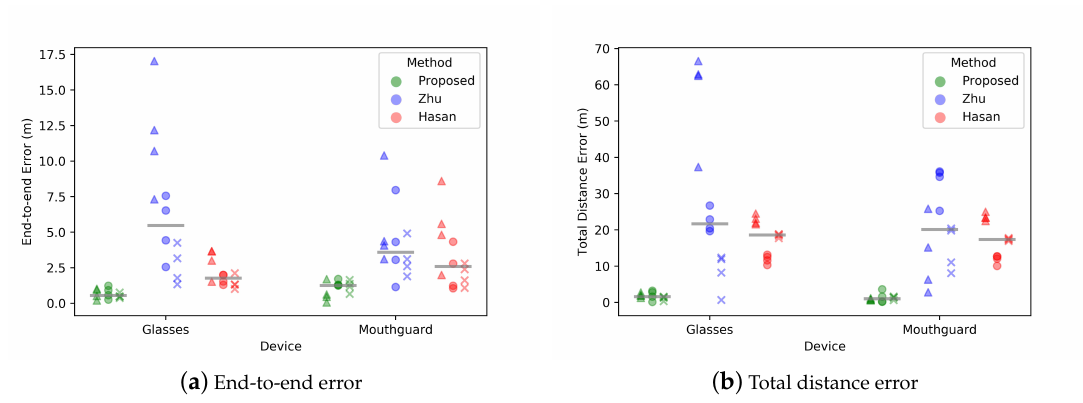
Figure 5. Errors across all subjects for each condition. Horizontal lines represent median values. A triangle is used to represent data from subject 1, a circle is given for subject 2 and data from subject 3 is shown as a cross.